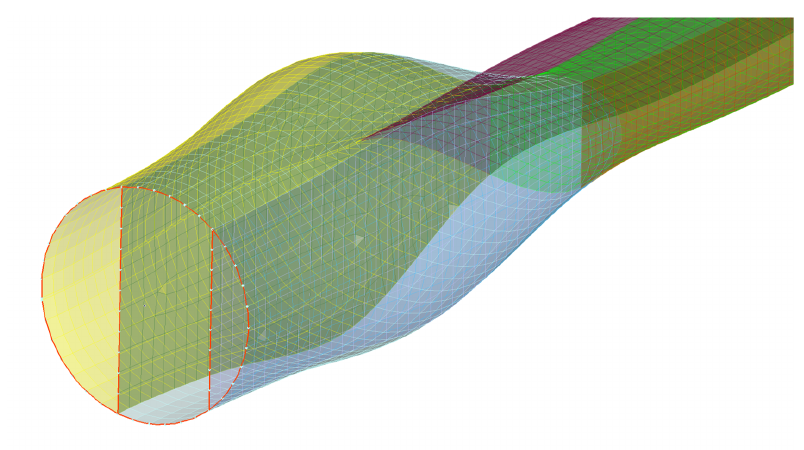
Figure 6. Load application to the structure using RBE3 element.